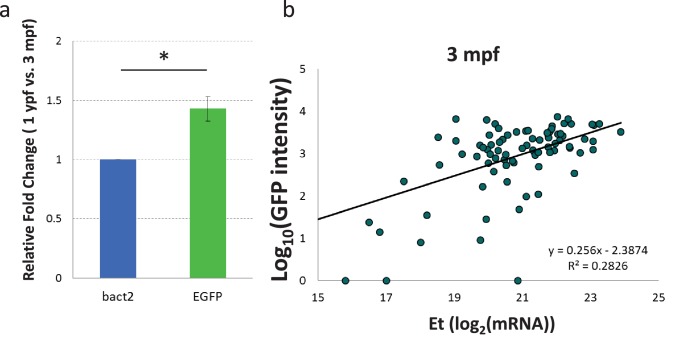
NF-kB:EGFP mRNA levels in beta-cells increase with age.(a) Graph showing the relative fold change increase in EGFP mRNA levels in beta-cells from 1 ypf compared to 3 mpf animals, as measured using RT-qPCR (n=5 biological replicates from three fish each, 1000 cells for each condition). Error bars show SD (two-tailed paired t-test, *p<0.05). (b) The graph shows the fluorescence levels of individual FAC-sorted beta-cells from Tg(nF-kB:GFP);Tg(ins:mCherry) animals as log10(GFP intensity) (along the Y-axis) and Expression threshold (Et) values of GFP mRNA (along X-axis) measured using single-cell RT-qPCR. Line indicates the correlation between GFP fluorescence intensity and GFP-mRNA expression levels in single cells. Each dot represents one beta-cell. R2 = 0.28.